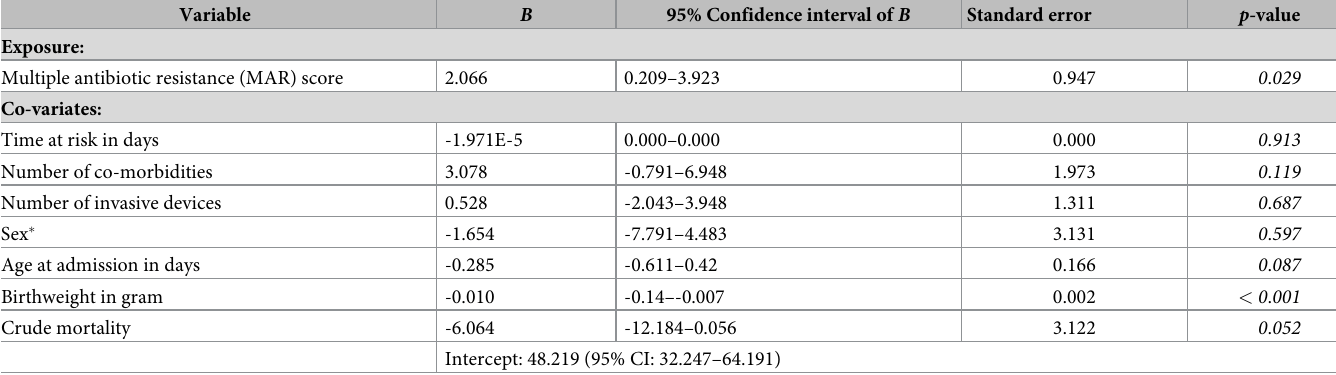
Table 5. Multiple linear regression model for ‘length of hospital stay’ (LOS) in days as outcome.